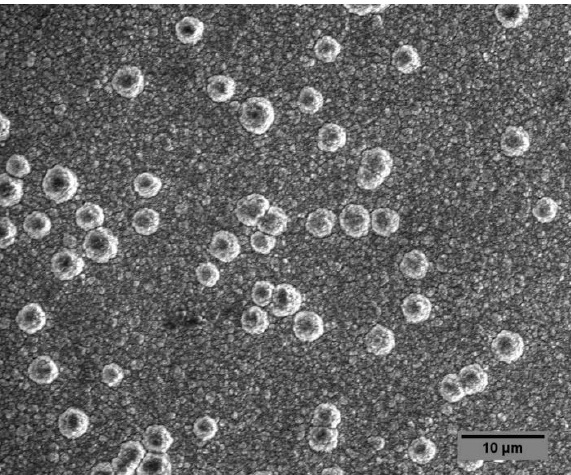
Figure 5. Scanning electron microscopy (SEM) image of bias-enhanced boron nitride coating. Mor- phology of the coating grown without applied bias is reported in our previous work [28] .